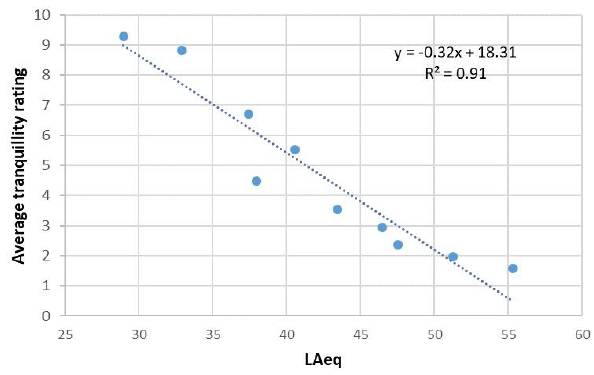
Figure 4: Tranquillity Ratings for National